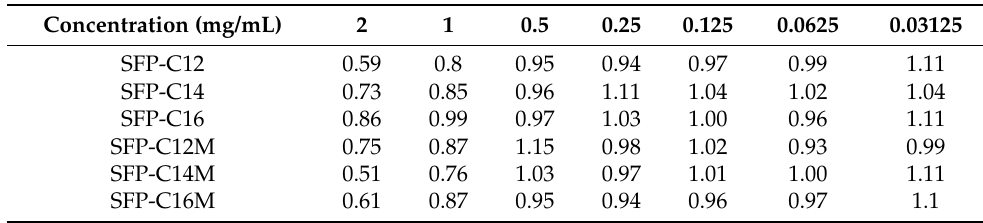
Table 4. Relative survival rate of DF-1 cells.